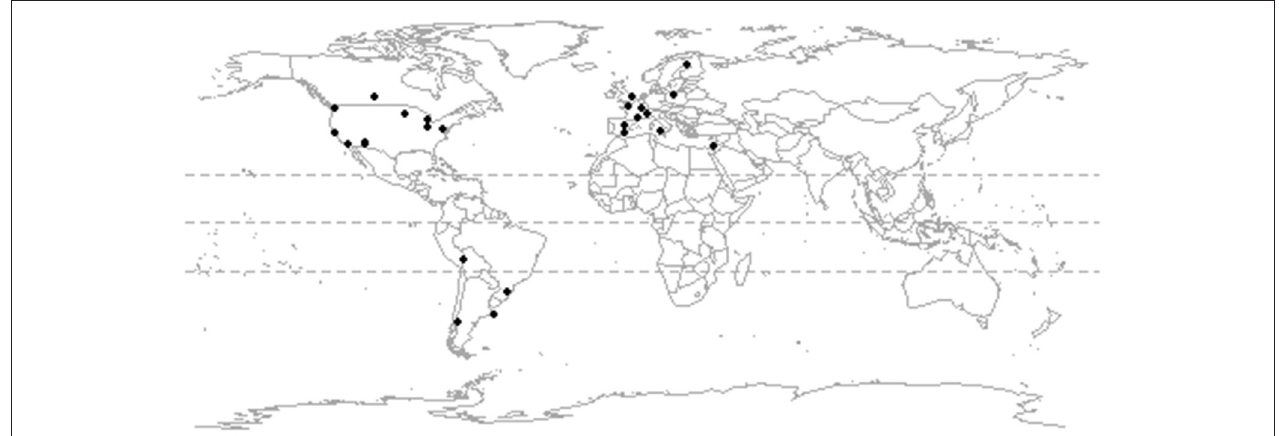
FIGURE 1 | The location of 25 study sites for which data were available on the composition of paired urban and rural assemblages.